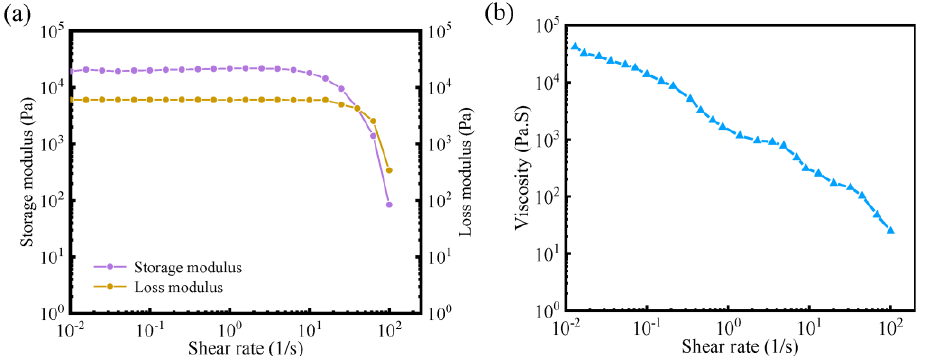
Figure 3. ( a ) Modulus diagram; ( b ) shear thinning.